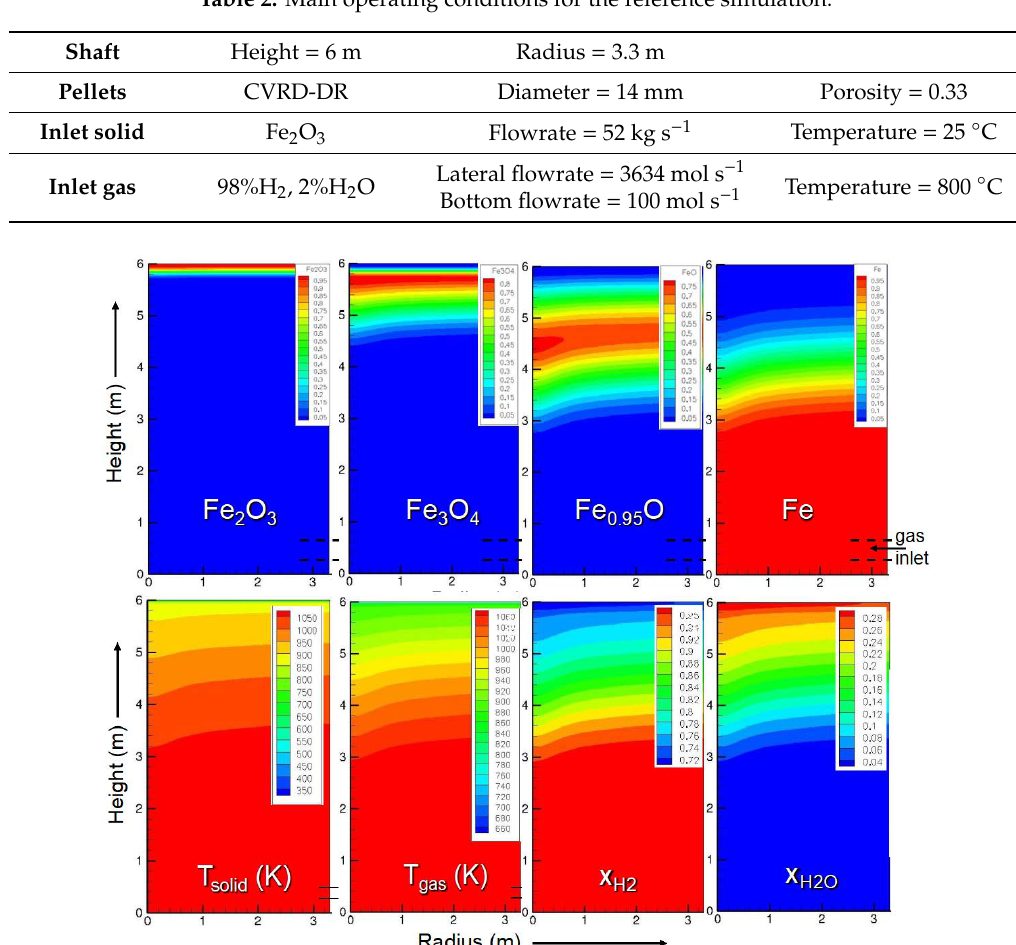
Figure 3. Main results of the shaft model. The calculations were performed under the conditions given in Table 1. Top row: solid mass fractions; bottom row: solid and gas temperatures, gas molar fractions in H 2 and H 2 O. The symmetry axis is on the left-hand side of each map, and the wall is on the right-hand side. The main gas inlet is at the wall near the bottom of the reactor.